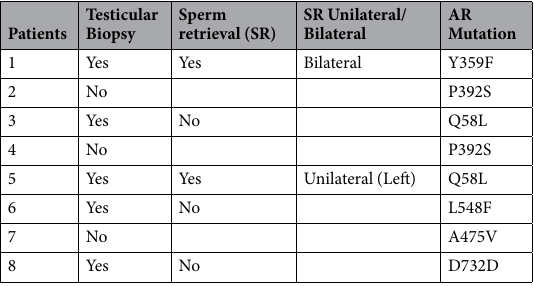
Table 3. Sperm retrieval in 8 KS mutation and type of